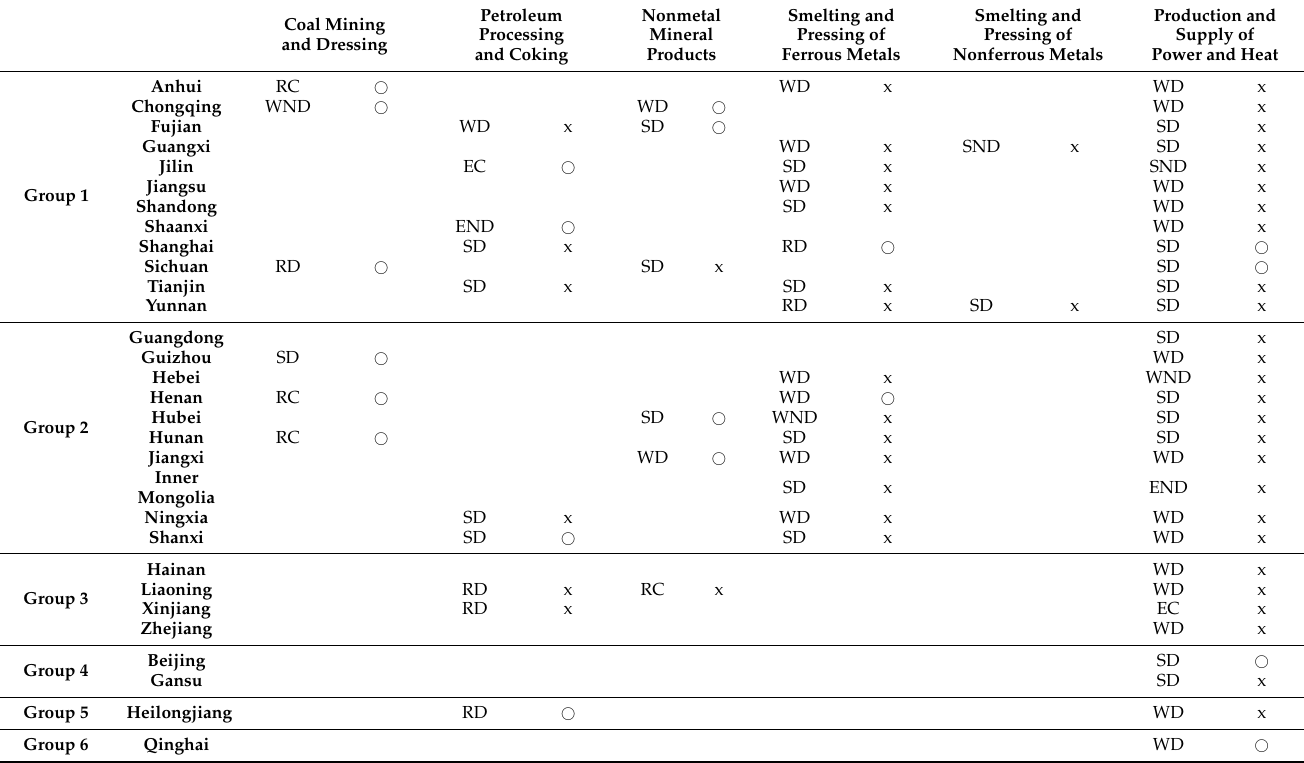
Table 3. Critical emission characteristics of the key industrial sectors of